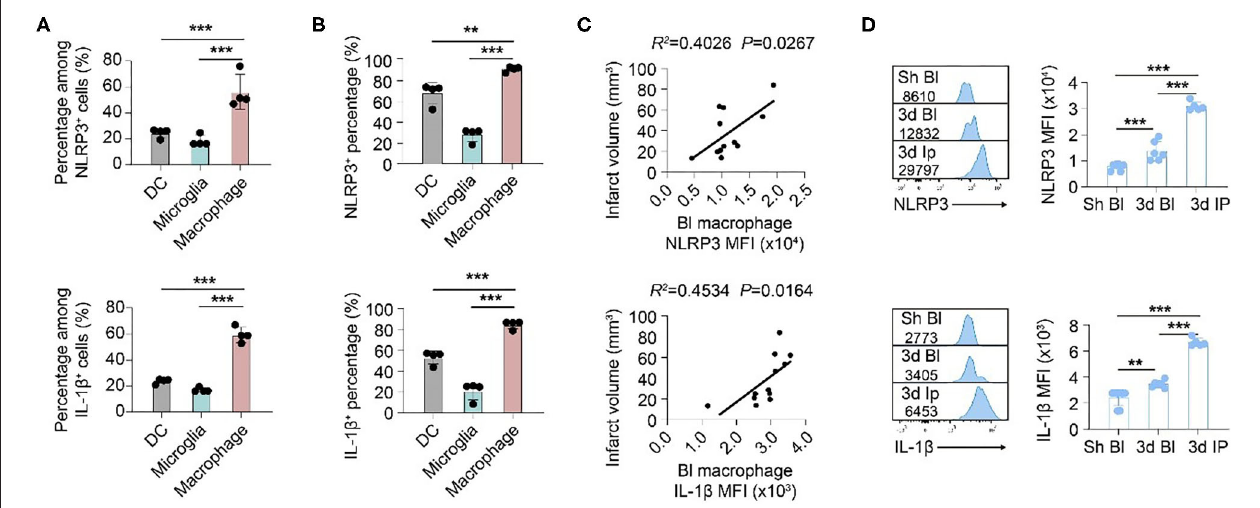
FIGURE 4 | Inflammasomes activate primarily in macrophages that infiltrate into ischemic lesions after stroke. WT C57/Bl6 mice were subjected to Sham operation or tMCAO. Mice were sacrificed at 3 d after tMCAO when inflammasome activation peaked. (A) Brain cells that expressed NLRP3 and IL-1 β were gated in flow cytometric analysis (FACS). Percentage in NLRP3 + or IL-1 β + cells of dendritic cells (DC, CD45 + CD11c + ), microglia (CD45 int CD11b + ), and macrophage (CD45 hi CD11b + F4/80 + ) was assessed. N = 4 mice. *** P < 0.001 in One-way ANOVA . (B) Percentage of NLRP3 and IL-1 β in dendritic cells (DC, CD45 + CD11c + ), microglia (CD45 int CD11b + ), and macrophage (CD45 hi CD11b + F4/80 + ) in ipsilateral brain was calculated with flow cytometry. N = 4 mice. *** P < 0.001 in One-way ANOVA . (C) Mean fluorescent intensity (MFI) of NLRP3 or IL-1 β in macrophages (CD45 hi CD11b + F4/80 + ) in the peripheral blood of mice was calculated. Correlation of NLRP MFI or IL-1 β MFI with infarct volume of mice at 3 d after stroke was analyzed with Linear regression . N = 10 mice. (D) NLRP MFI or IL-1 β MFI in macrophage (CD45 hi CD11b + F4/80 + ) in peripheral blood (Bl) of Sham (Sh) operated mice, peripheral blood of mice at 3 d after tMCAO and ipsilateral (Ip) brain was analyzed with flow cytometry. N = 4 mice. ** P < 0.01, *** P < 0.001 in One-way ANOVA .